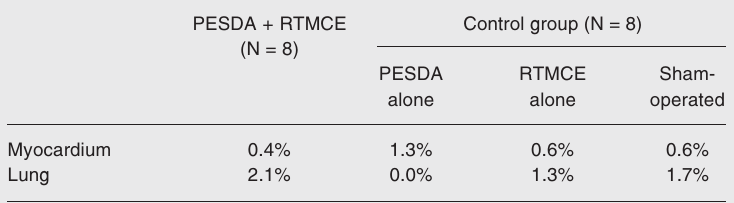
Table 2. Mean percentages of 100X microscopical fields presenting microhemorrhage in myocardium and lung sections.